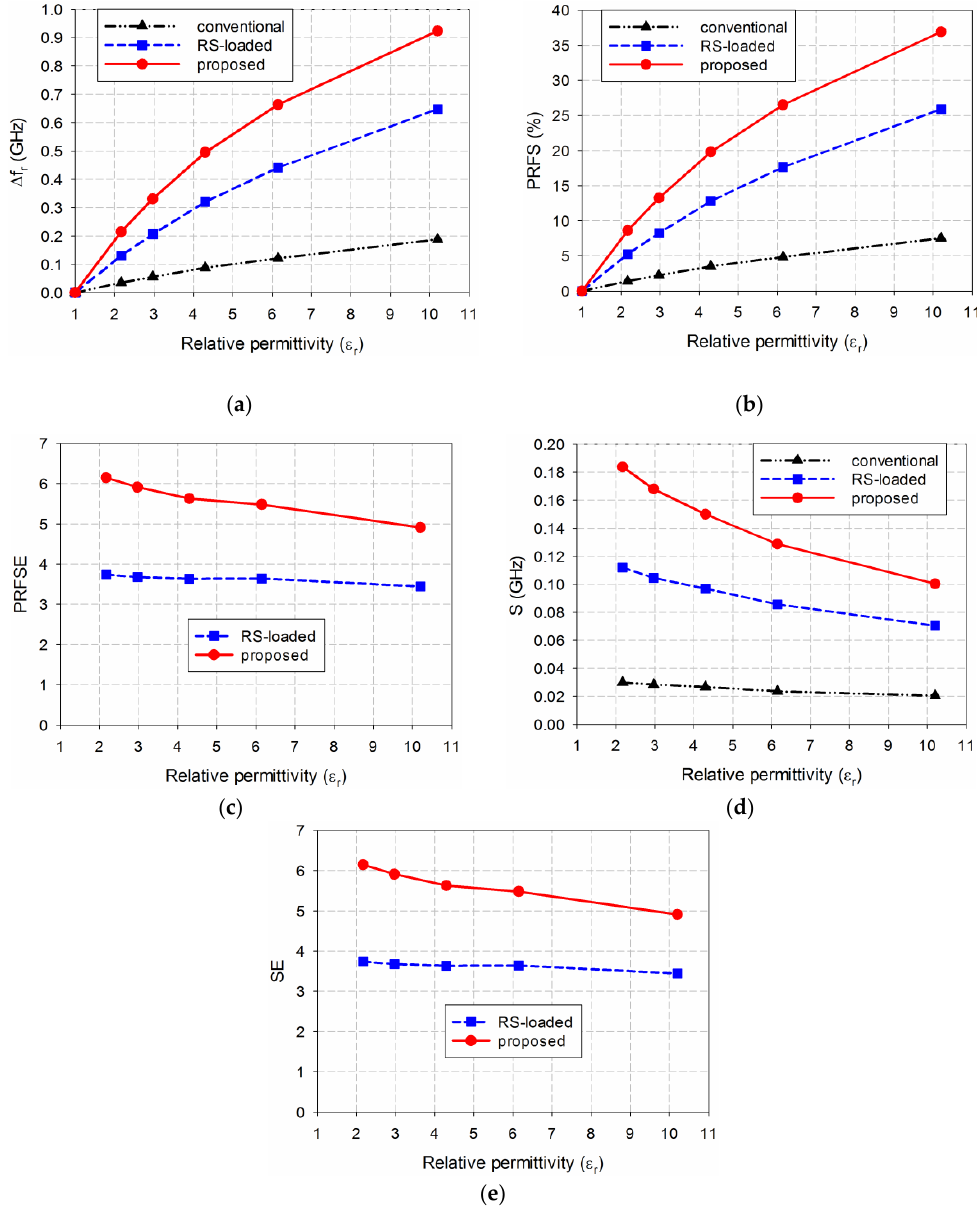
Figure 10. Simulated sensitivity comparison of the three MPASs for the MUTs in Table 2: ( a ) Δ f r ; ( b )